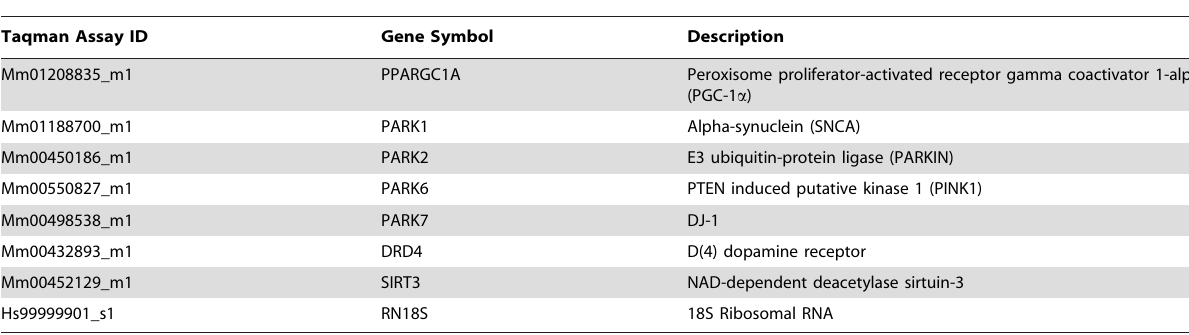
Table 1. Taqman assays used for quantitative RT-PCR.